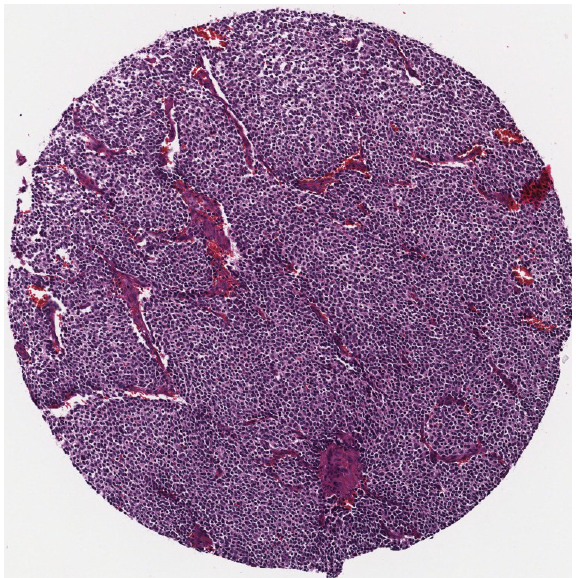
Figure 3. A sample of a single